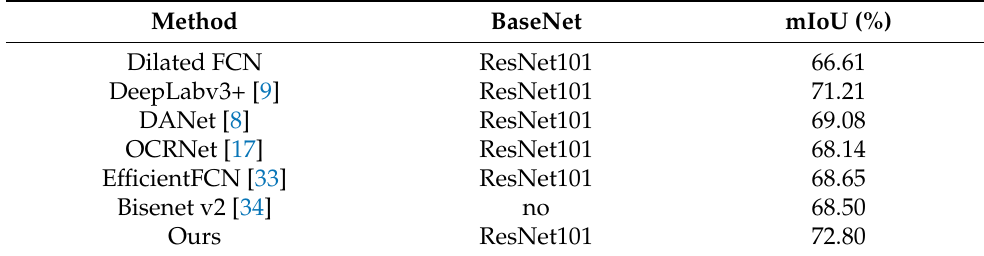
Table 5. Segmentation results on cityscapes validation